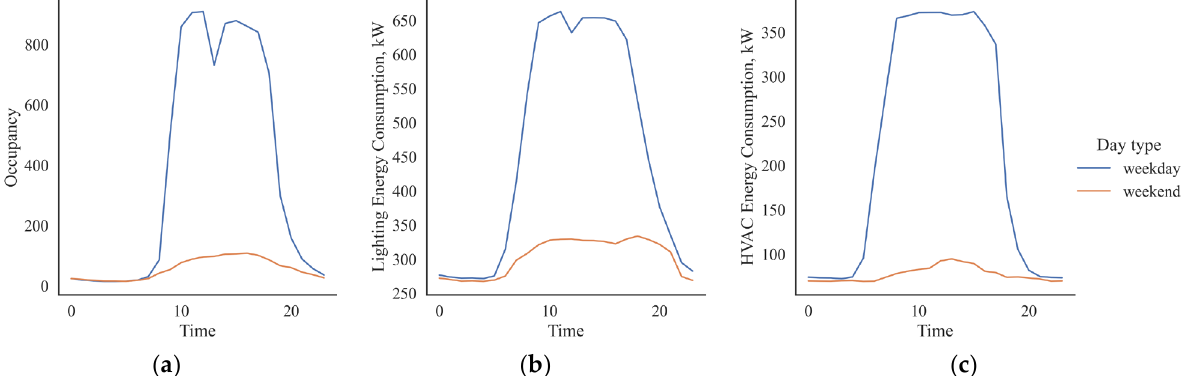
Figure 6. ( a ) Average daily occupancy, ( b ) average daily lighting energy consumption and ( c ) average daily HVAC energy consumption.